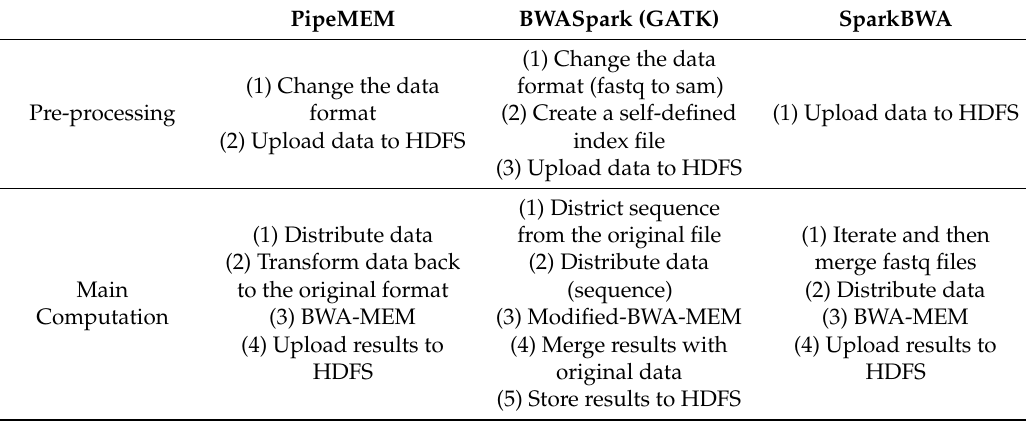
Table 1. Di ff erences between PipeMEM, BWASpark (GATK), and